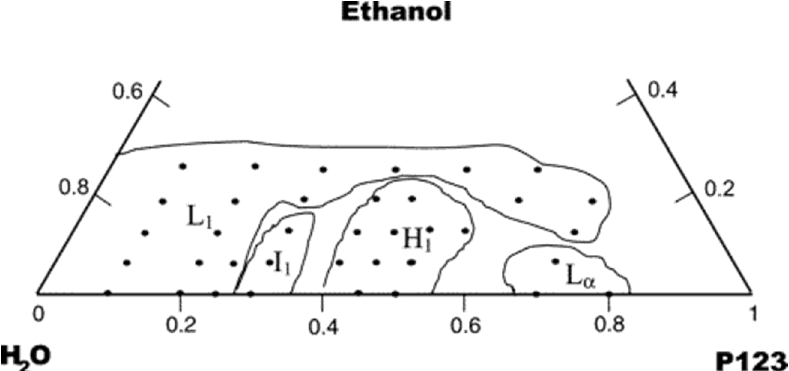
Figure 4. Ternary phase diagram of P123–water–ethanol system at T = 23 °C. L1 denotes the region with isotropic solution (water-rich), I1 refers to isotropic gels, H1 refers to cylindrical micelles arranged in a 2D hexagonal lattice, and L α is the lamellar phase. The region boundaries are traced by solid lines [39].